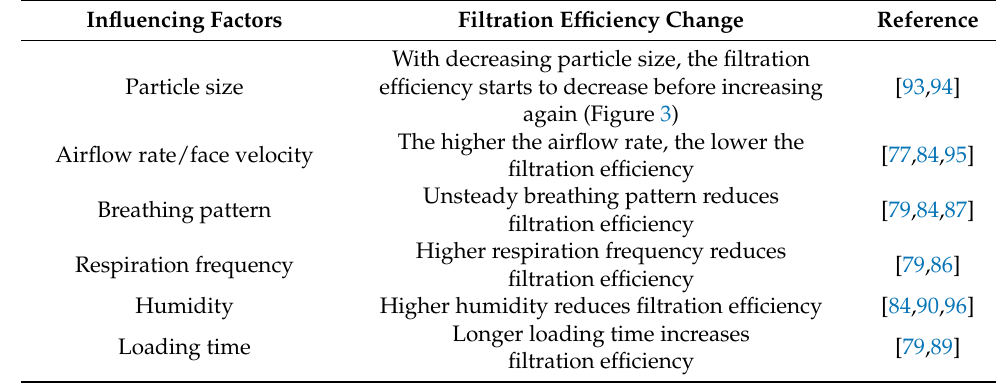
Table 1. Environmental and human factors that influence RPD filtration